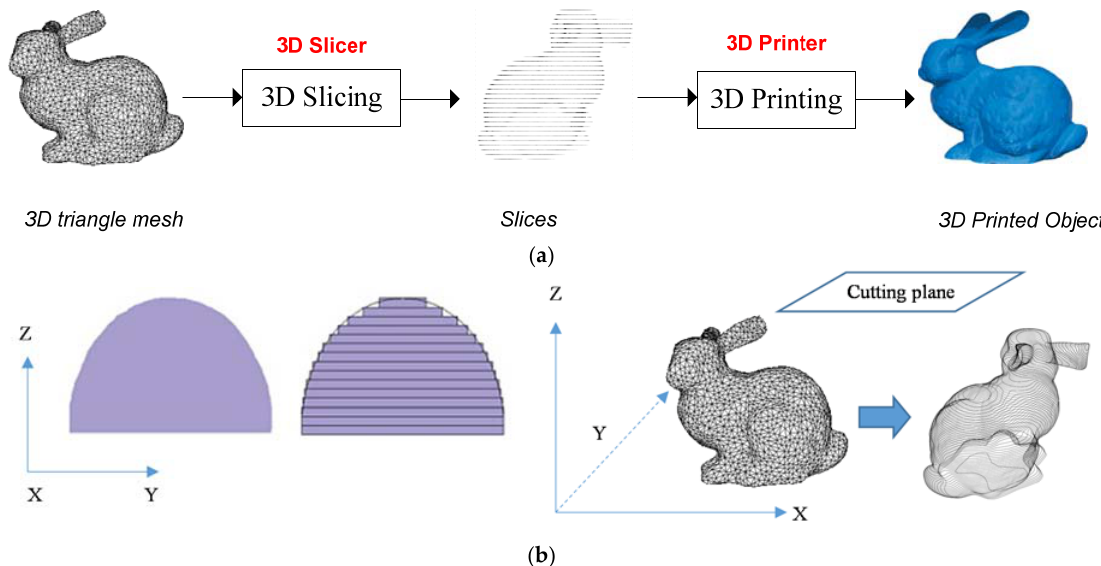
Figure 1. ( a ) General three-dimensional (3D) Printing Process; ( b ) 3D Triangle Mesh Slicing in OYZ space and in OXYZ space.